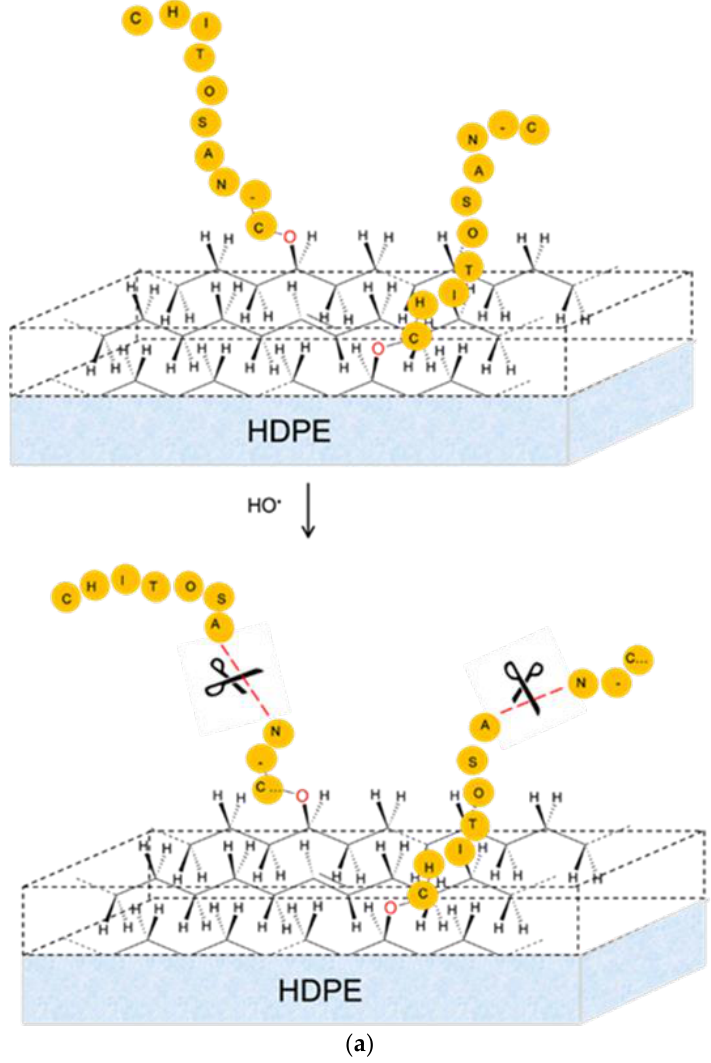
Figure 3. Contact angle values obtained for HDPE surfaces grafted with chitosan at different reaction times. HDPE samples were previously irradiated at ( A ) 50 kGy and ( B ) 100 kGy.